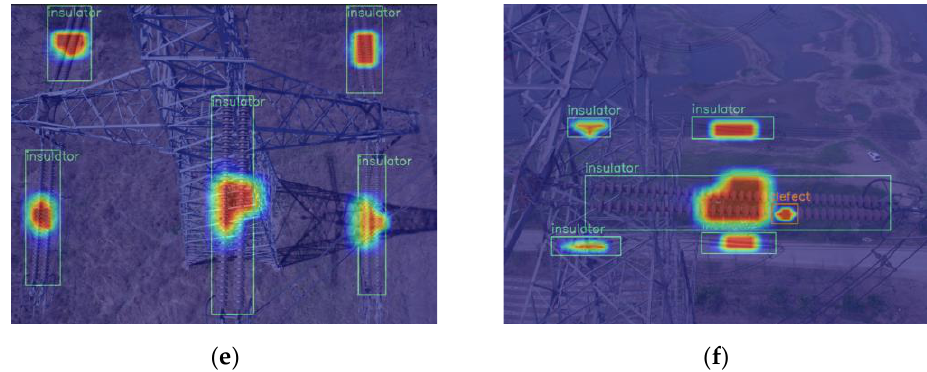
Figure 11. Heat map of the detection of the DSMH-YOLOv4 model. ( a ) Seven insulators have been detected; ( b ) four insulators and a defect have been detected; ( c ) six insulators have been detected; ( d ) one insulator and two defects have been detected; ( e ) five insulators have been detected; ( f ) five insulators and a defect have been